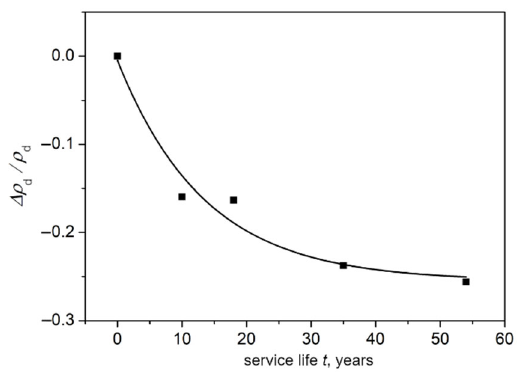
Figure 8. Dependence of the integral value of the density defect in A50 wires on the service life during operation up to 54 years.